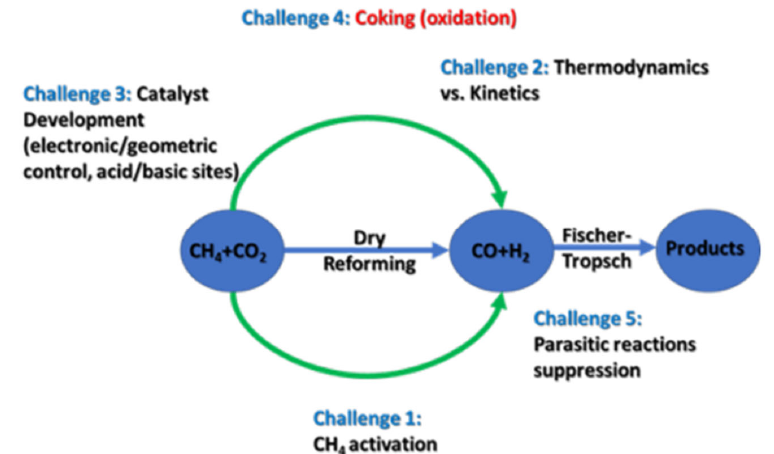
Figure 6. Challenges in the dry reforming of methane reaction .